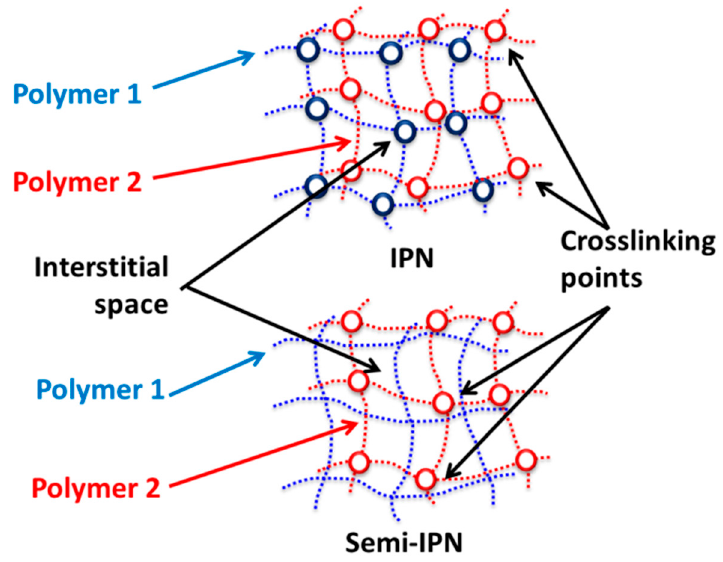
Figure 3. Schematic of IPN and semi-IPN systems. IPNs show cross-linking of both the polymer phases whereas the semi-IPN shows only one phase phases whereas the semi-IPN shows only one phase cross-linking.